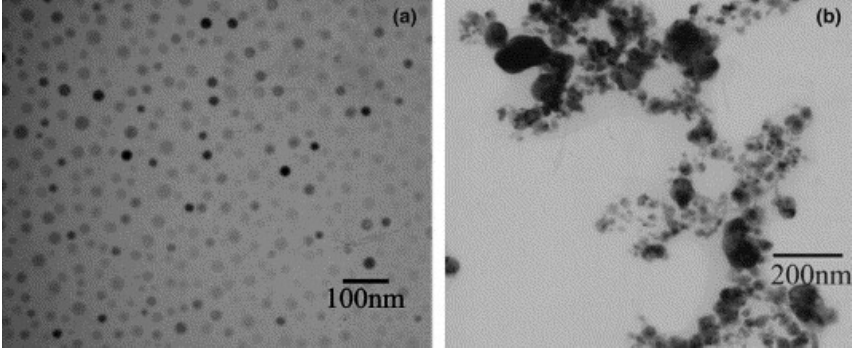
Figure 3. Silver nanoparticles prepared under different current density: (a) 70 and (b) 140 mA cm -2 . Reprinted from Ref. [49] with permission from